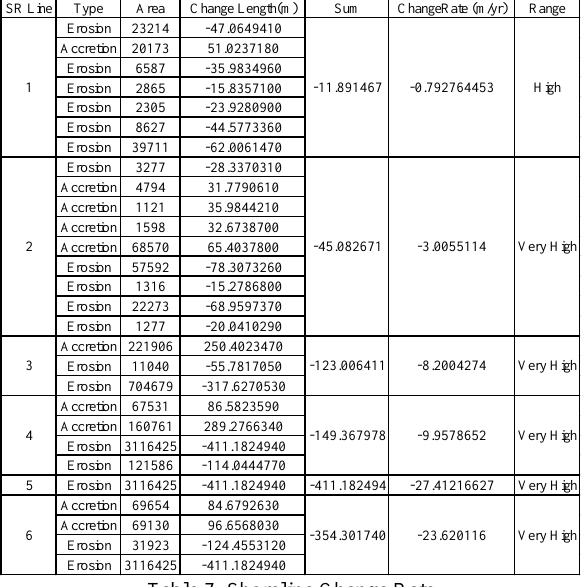
Figure 15. Coconut Size Effected to Coastline Changes Figure 16 below show coconut tree are destroy causes by coastline changes.